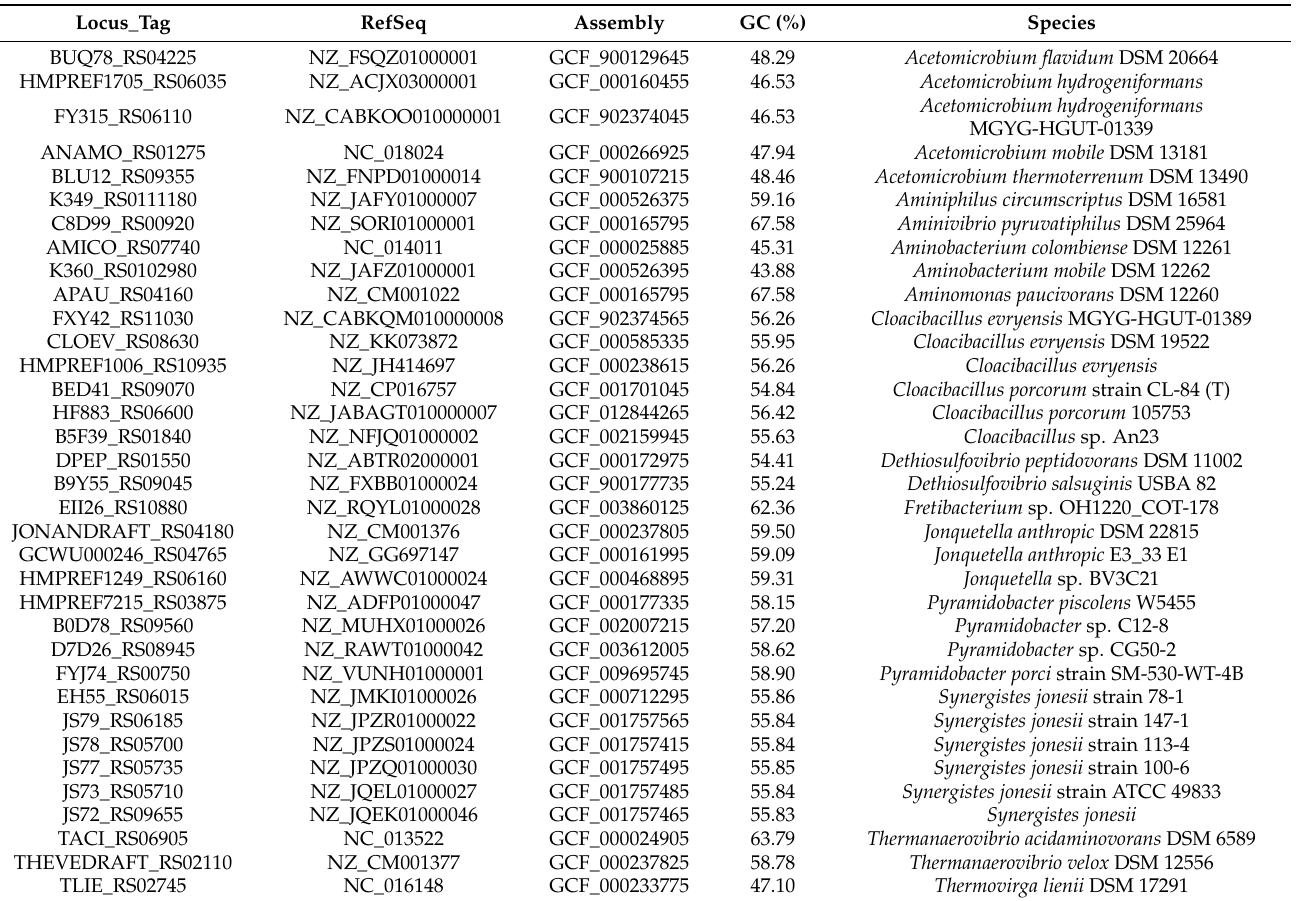
Table 1. The distribution of the putative CodY-like protein among the cultivable species of the phylum